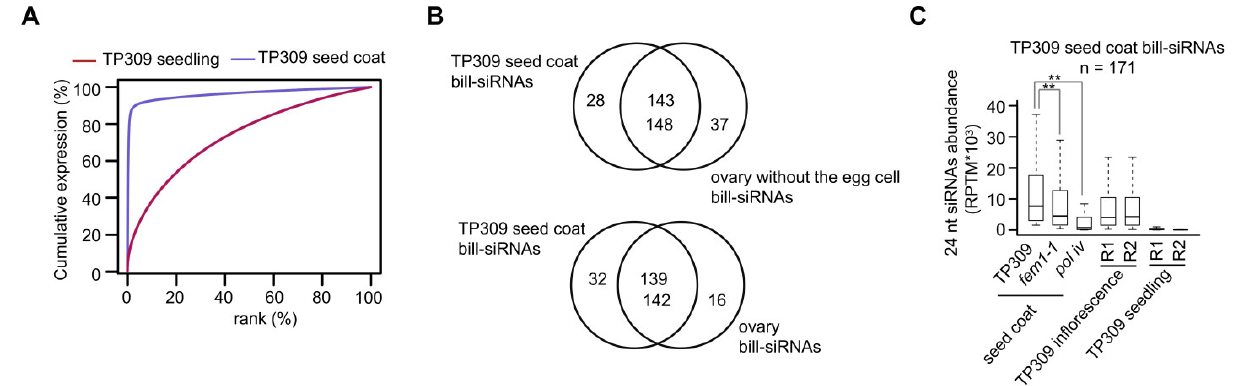
Figure 8. Bill-siRNAs derived from the ovary are retained in the seed coat. ( A ) Cumulative expression plot of 24 nt siRNA clusters in seedlings and seed coats in TP309 background. ( B ) Overlap for bill-siRNA clusters in the seed coat and in the ovary without the egg cell (upper), and in the ovary with egg cell (lower). ( C ) Boxplots showing siRNA abundance in the indicated tissues on TP309 seed coat bill-siRNA clusters. ** indicates p < 0.01 by the Wilcoxon sum test.